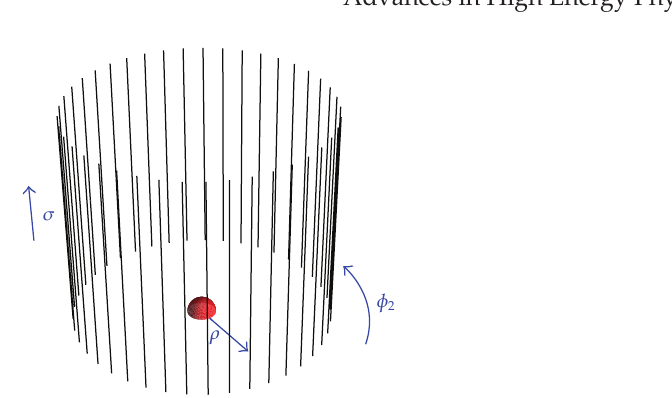
Figure 9: A qualitative plot of the situation with cohomogeneity 2 models. The red dot in the center represents the color branes and each vertical line is a flavor brane. Taking a lot of them smeared along the φ 2 angle, the rotational symmetry associated to this angle is e ff ectively recovered. Any function of the ansatz depends on the radial coordinates ρ and σ .